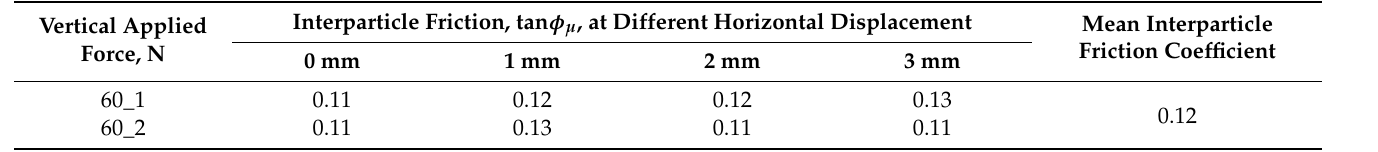
Table 2. The calculated interparticle friction under 60 N normal load.